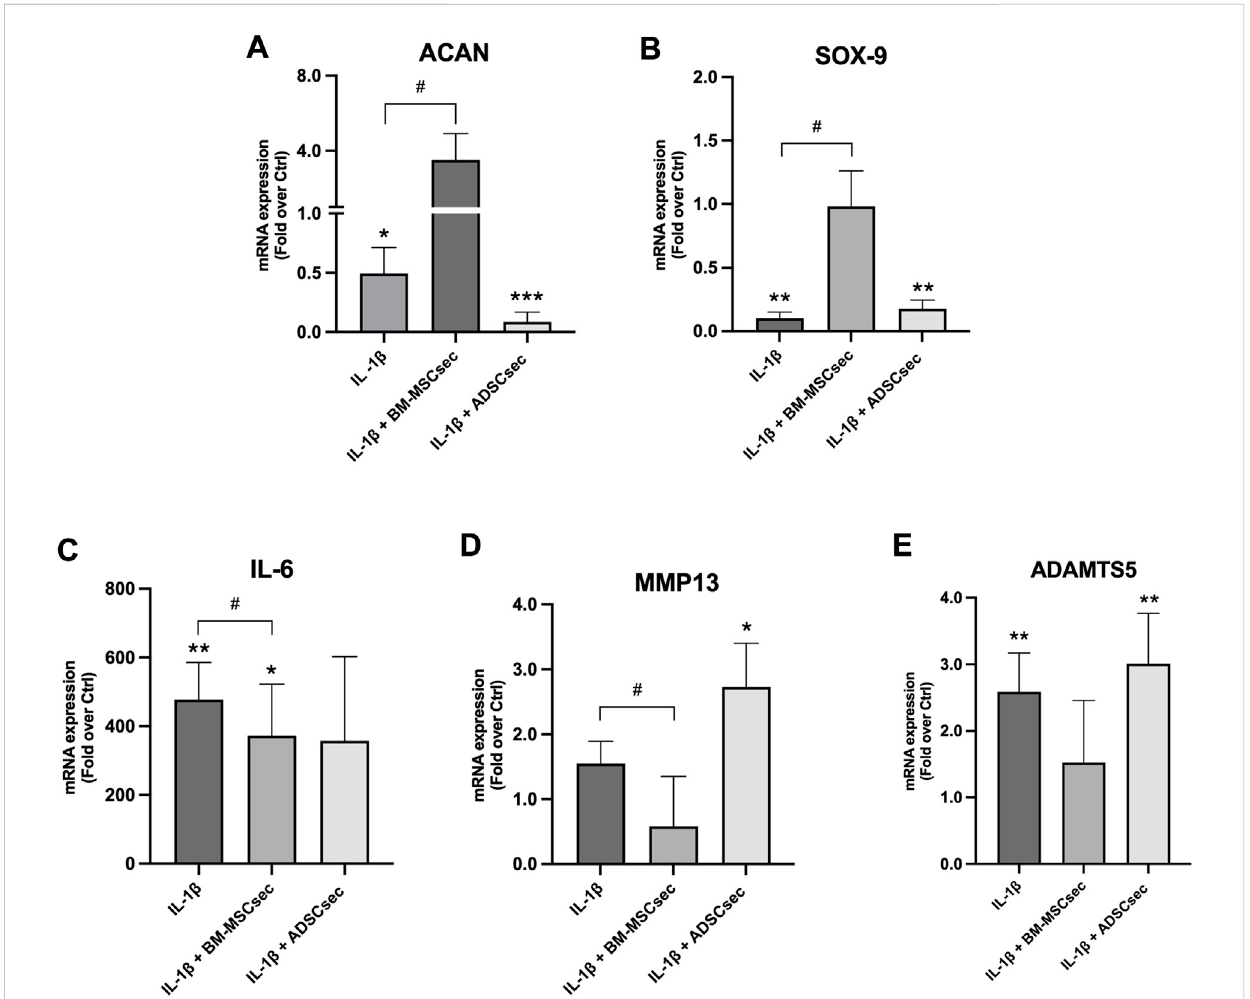
FIGURE 8 MSC secretomes differentially impacted on hNPC ECM and catabolic marker gene expression following IL-1 β pretreatment. BM-MSCsec signi fi cantly rescued the expression of ACAN (A) and SOX9 (B) genes, while signi fi cantly reducing IL6 (C) , ADAMTS5 (D) and MMP13 (E) gene expression following IL-1 β pretreatment. Conversely, ADSCsec signi fi cantly reduced the expression of both ACAN and SOX9 , while increasing catabolic marker levels. Results were normalized based on GAPDH expression and calculated as fold change compared to the controls. * p < 0.05, ** p < 0.01, *** p < 0.001, # p < 0.05 compared to IL-1 β